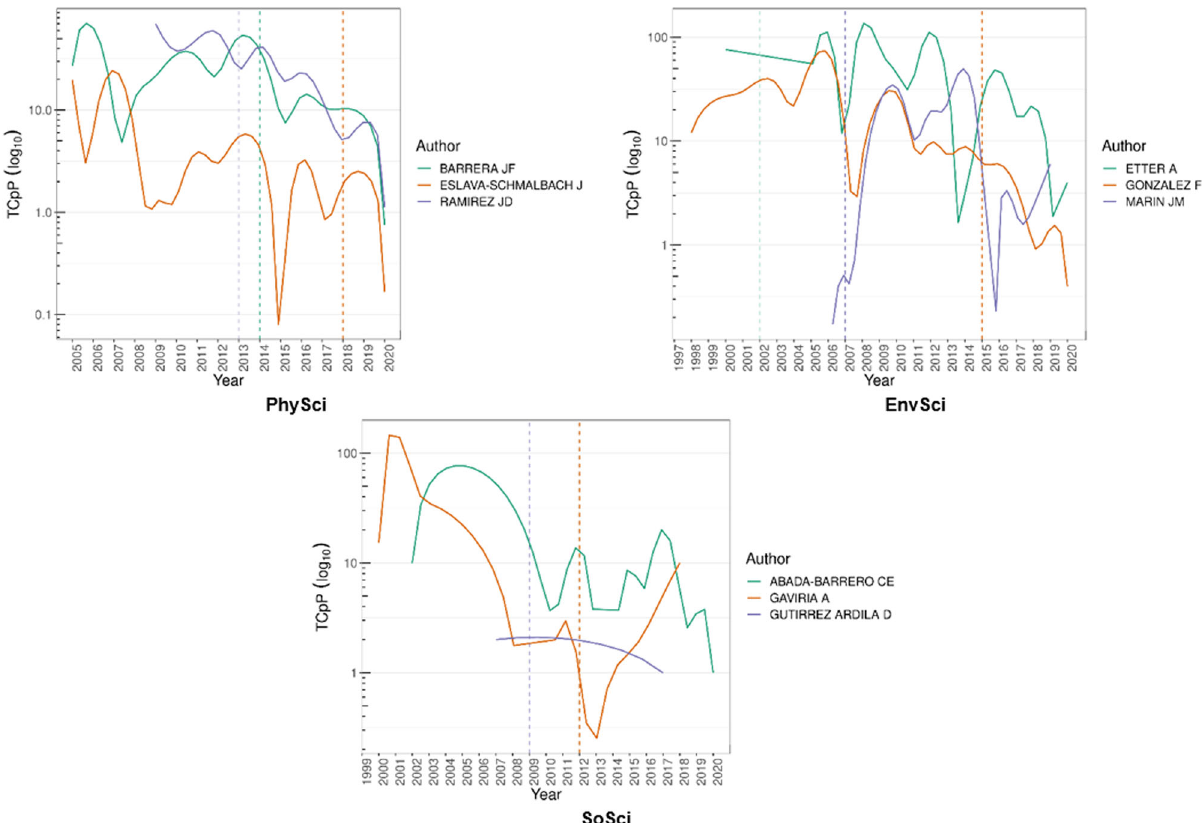
Fig. 4 Citations per article by category of top-three most cited researchers for sCSE. Source: the authors based on AAEF (Fundación Alejandro Ángel Escobar, 2007, 2020) and Scopus (2020b). Note: the dashed line points to the year each researcher was awarded the AAEP special mention; TCpP: citations per